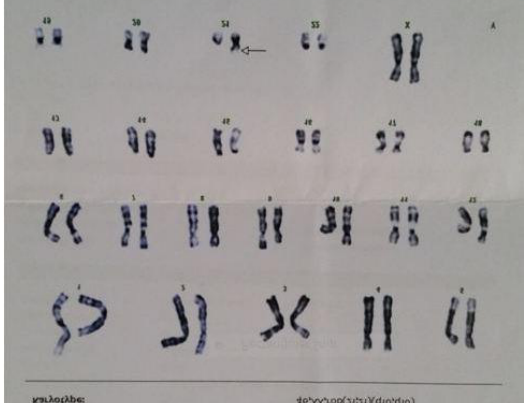
Figure 01: Karyotype of the index